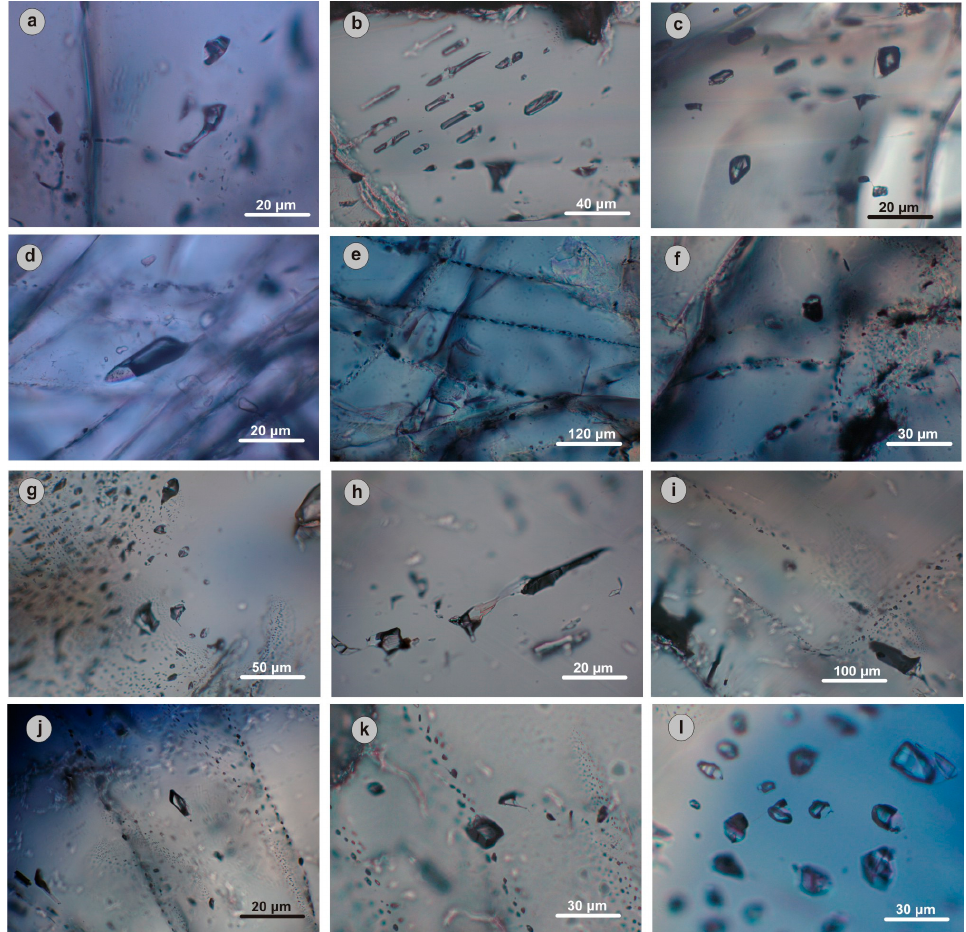
Figure 6. Photomicrographs of FI in corundums from the Rhodope massif of Greece, Paranesti and Gorgona ( a – f ) and from Naxos island the Attic-Cycladic massif ( g – l ). ( a ) Isolated primary two-phase vapor-liquid inclusions composed of CO 2 ± (CH 4 and/or N 2 ). The fluid inclusion at the upper part has a negative crystal shape, and the inclusion underneath shows necking-down deformation (Drama, thin-section Dr2). ( b ) Pseudosecondary two-phase carbonic FI along a fracture healed during crystal growth (Xanthi, thin-section Go5a). ( c ) Primary two-phase carbonic FI (Xanthi, thin-section Go5a). ( d ) Two-phase carbonic inclusion which shows evidence of post-entrapment modification (brittle crack and halo of neoformed inclusions) (Xanthi, thin-section Go5b). ( e ) Tiny FI along fracture plane trails, but due to their small size no phases can be identified (Xanthi, thin-section Go1b). ( f ) Isolated two-phase carbonic inclusion (Xanthi, thin-section Go1b); ( g ) Oriented cluster of pseudosecondary carbonic FI along fractures healed during crystal growth (thin-section, Nx1a). ( h ) Isolated primary two-phase carbonic inclusion with necking-down deformation (thin-section, Nx1a). ( i ) FI along growth zones of the corundum (thin-section, Nx1a). ( j , k ) Primary two-phase carbonic FI (thin-section, Nx2a). ( l ) Pseudosecondary two-phase carbonic FI along a fracture healed during crystal growth (thin-section, Nx2b).